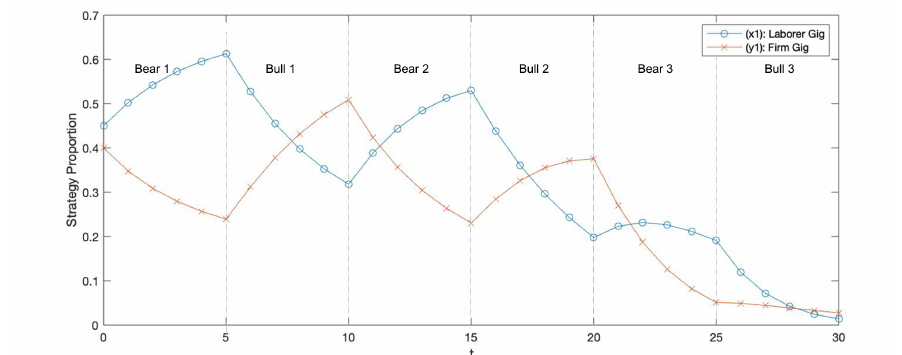
Figure A5. Escape demonstration with initial conditions ( 0.45,0.40 ) , ω = 0.1 and n = 0 and theoretical GameState pair, see Figure 1.